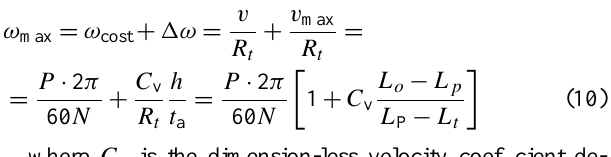
expressed as a function of the input parameters. Numerical results are obtained in this section for a real wrapping ma- chine with the parameters shown in Table